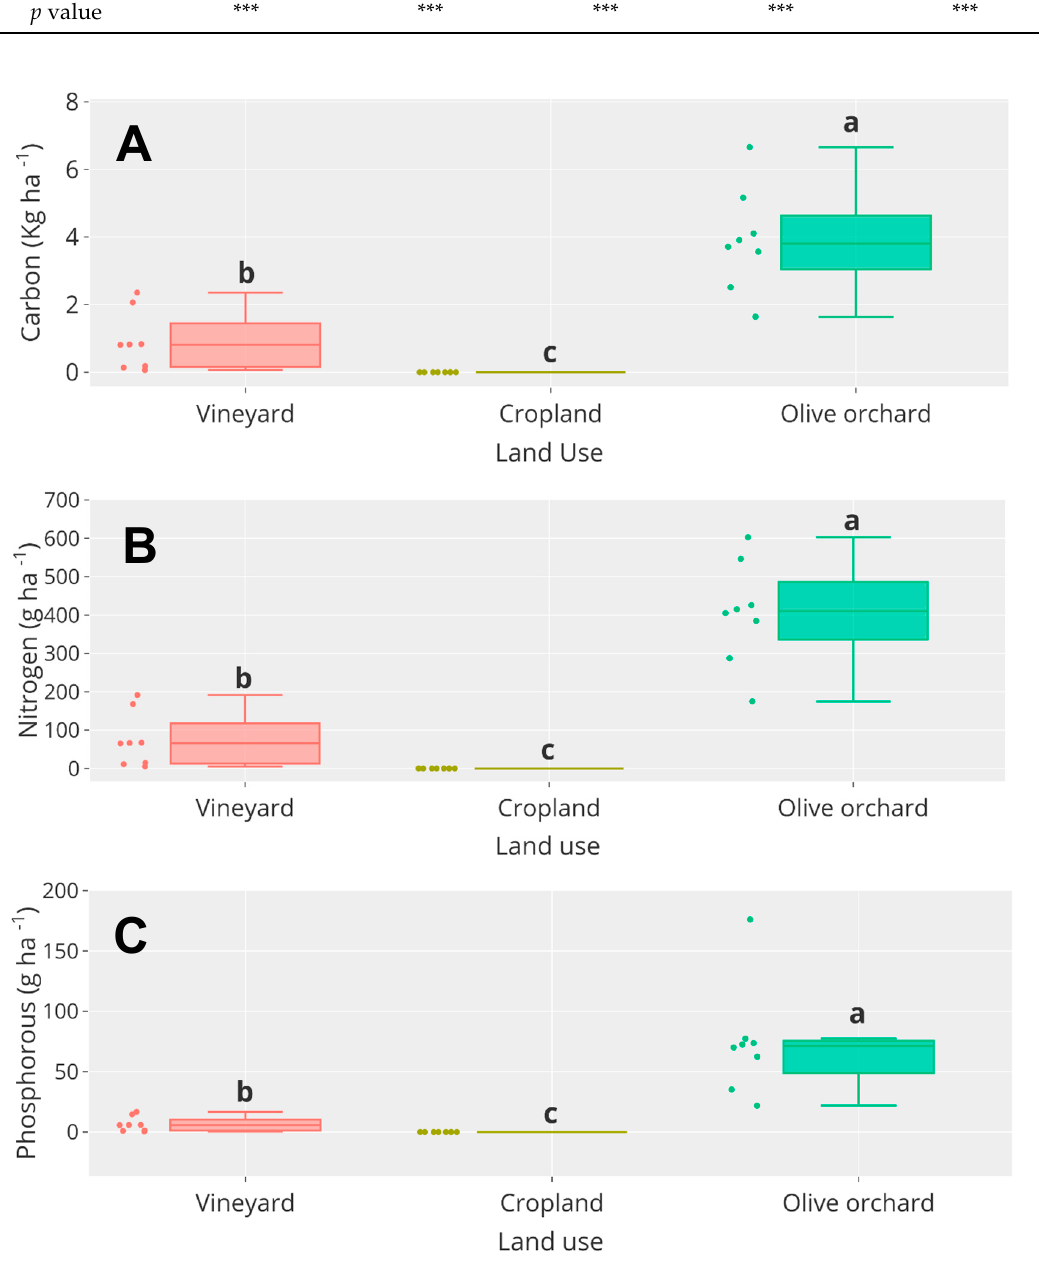
Figure 2. Nutrients loss in runoff: ( A ) Carbon, ( B ) Nitrogen, ( C ) Phosphorus. Different lower case letters represent significant differences at a p < 0.05.